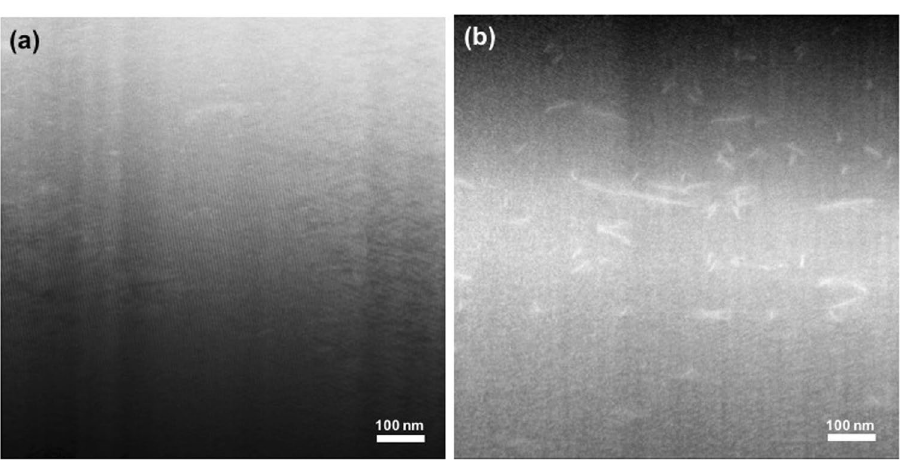
Figure 7. TEM HADDF images of hot pressed p-type ( a ) and n-type ( b ) with